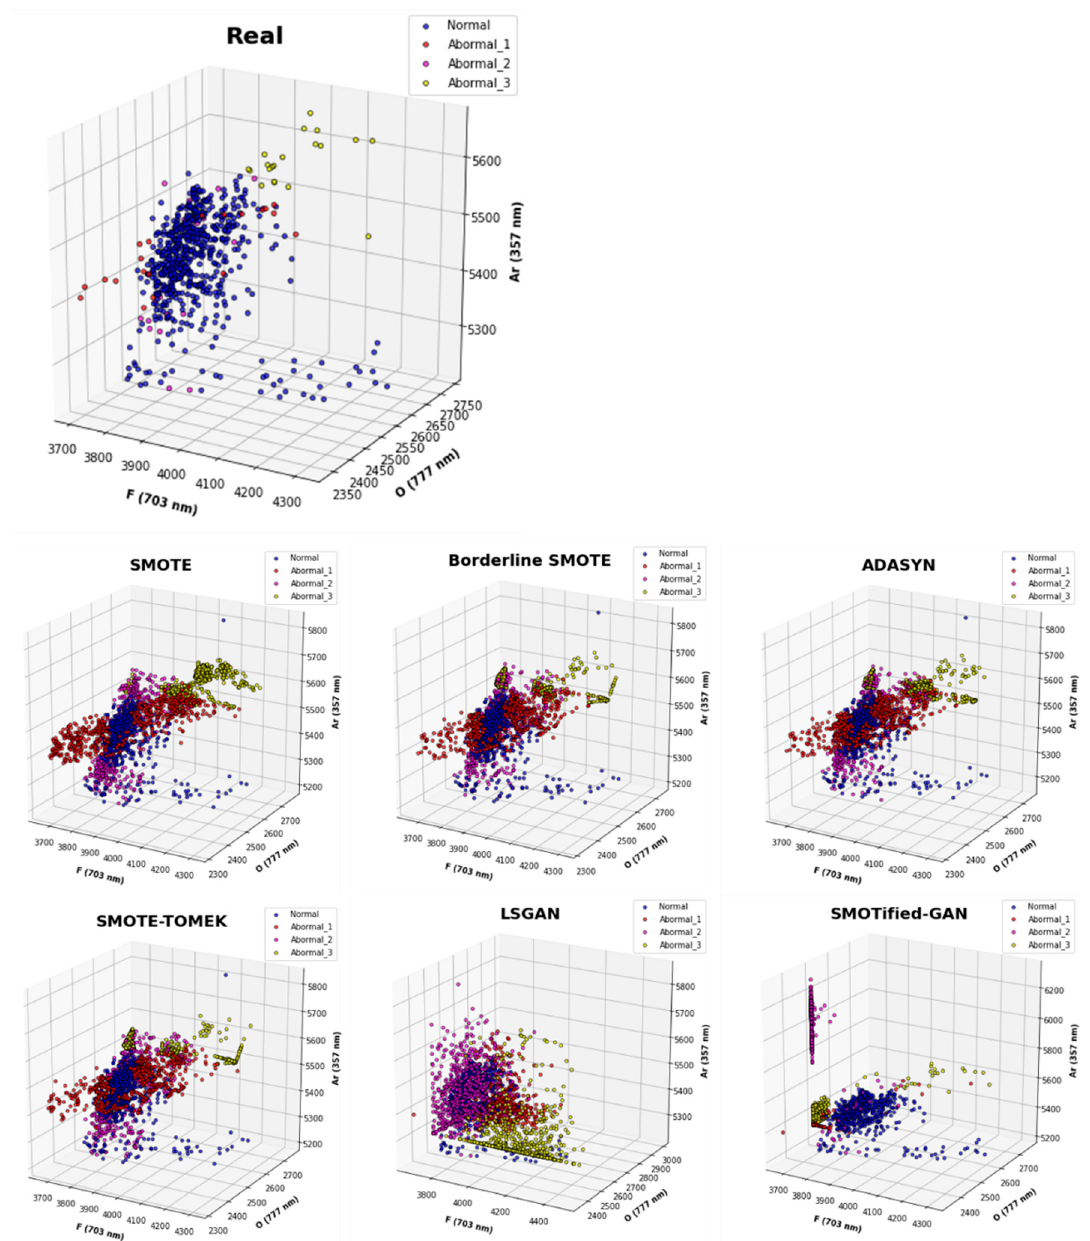
Figure 6. Results of oversampling and undersampling.